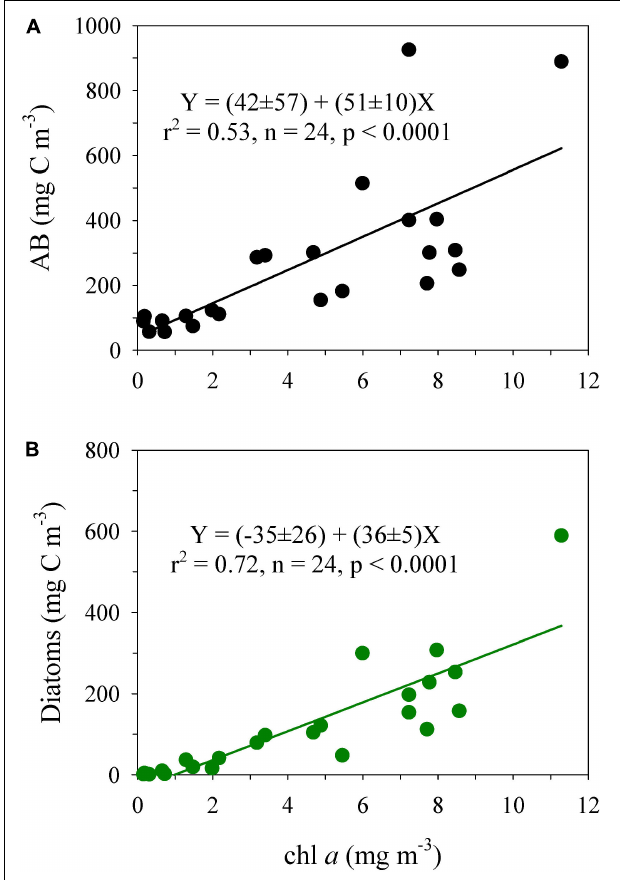
FIGURE 6 | Relationship between the chlorophyll a concentration (chl a ) and (A) the total autotrophic biomass of microbial plankton (AB) and (B) biomass of diatoms. The intercepts were not significant for the two relationships.